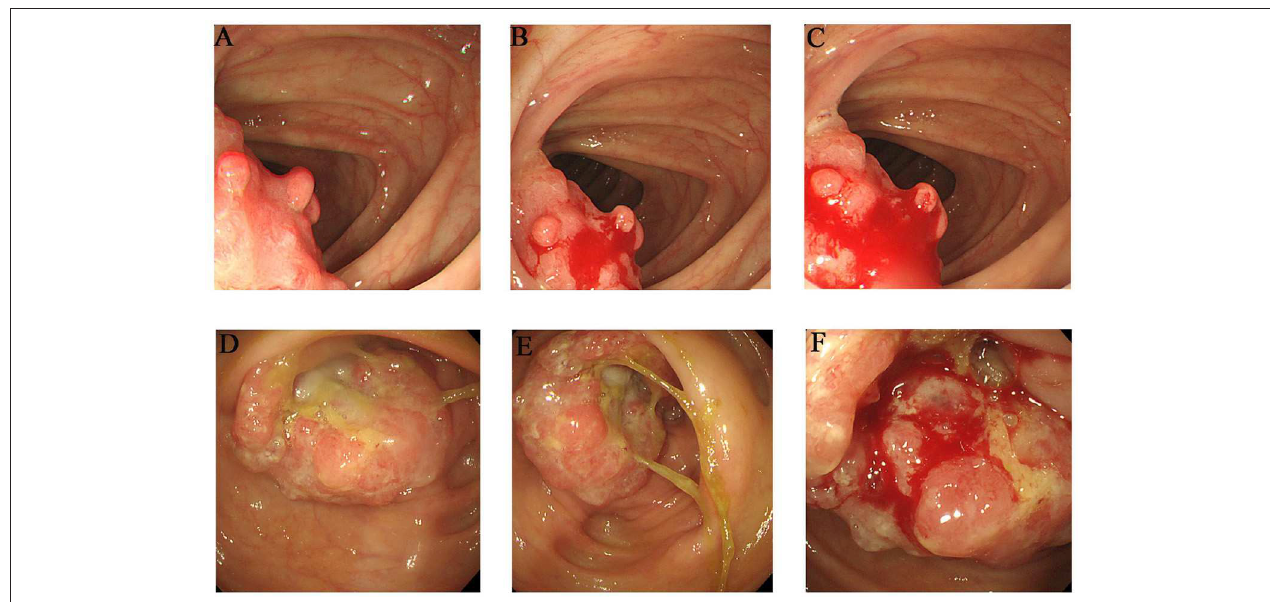
FIGURE 1 | Clinical description. Colonoscopies. (A–C) Transverse colon, with a neoplasm measuring 2 * 2cm (III-1). (D–F) Ascending colon, showing an irregularity- about 3.0cm of elevated mucosa (II-1).